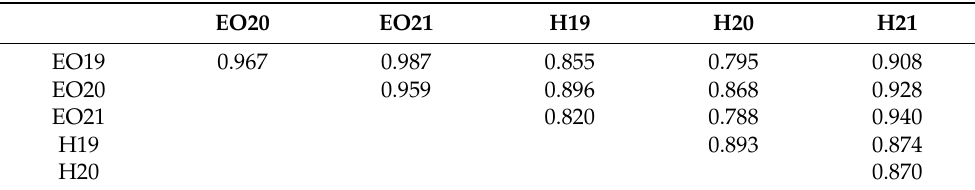
Figure 4. The PCA biplot diagram depicting the relationships among hydrolate and essential oil compounds of L. x intermedia cv. ‘Budrovka’ samples from three growing years: ( a ) projection of variables and cases in the PC1 and PC2 plane, ( b ) projection of variables and cases in PC1 and PC3 plane (active compounds codes and samples codes are listed in Tables 3 and 5). Table 5. Correlation matrix between active compounds content in hydrolate and essential oil of L. x intermedia cv. ‘Budrovka’ samples from 2019, 2020, and